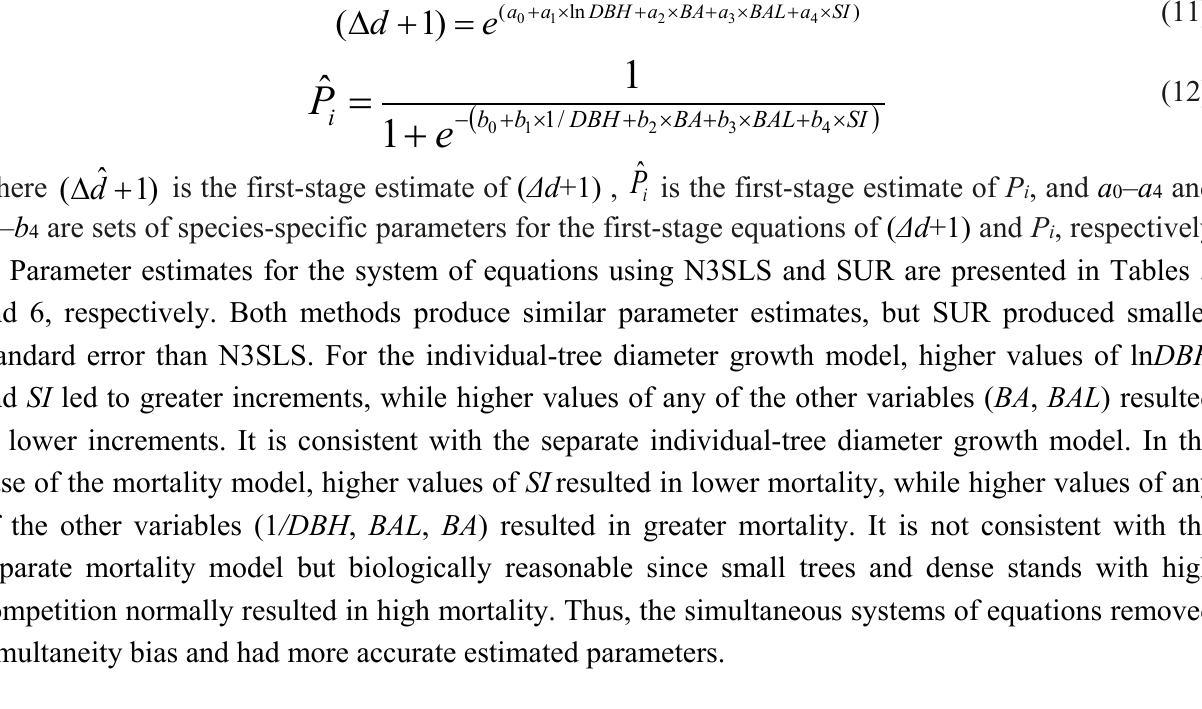
Table 5. The parameter estimates from N3SLS regression of ( Δ d +1) and P i in the system of equations for Mongolia oak ( n =